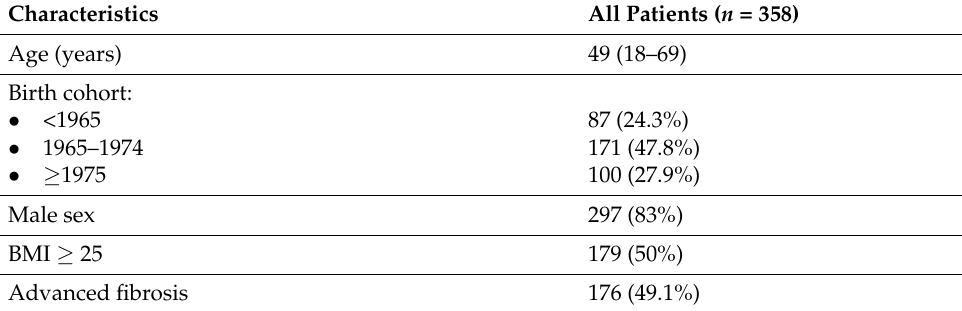
Table 1. Characteristics of PWID with CHC started treatment.